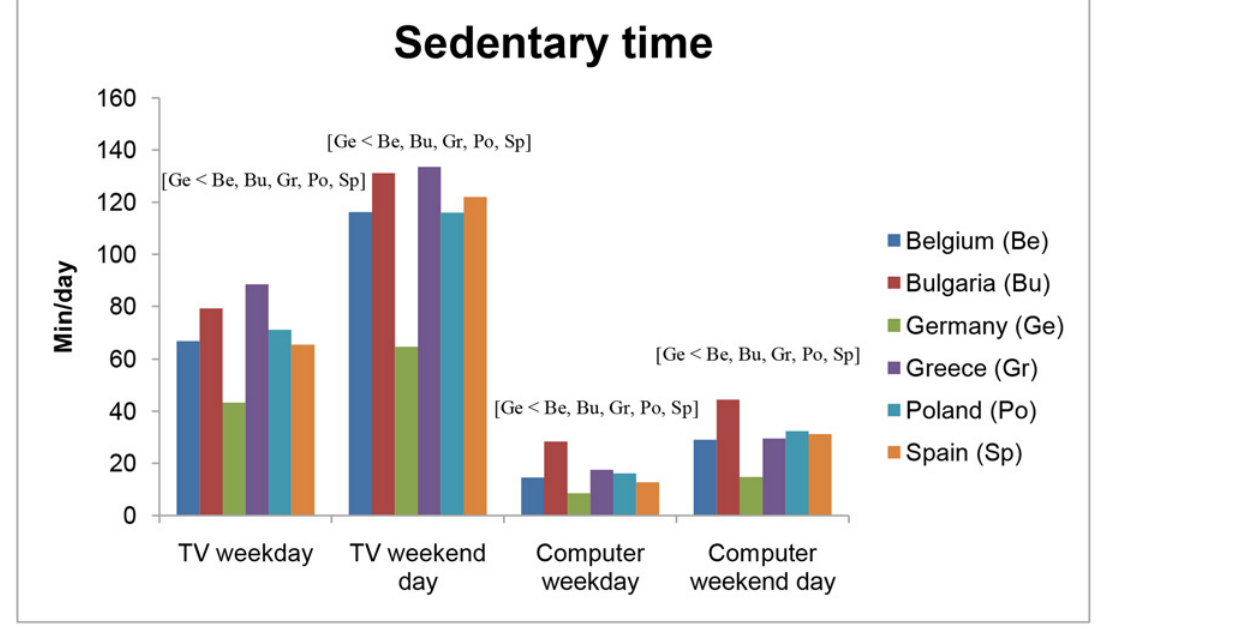
Fig 2. Differences in preschoolers ’ sedentary time across countries. TV =